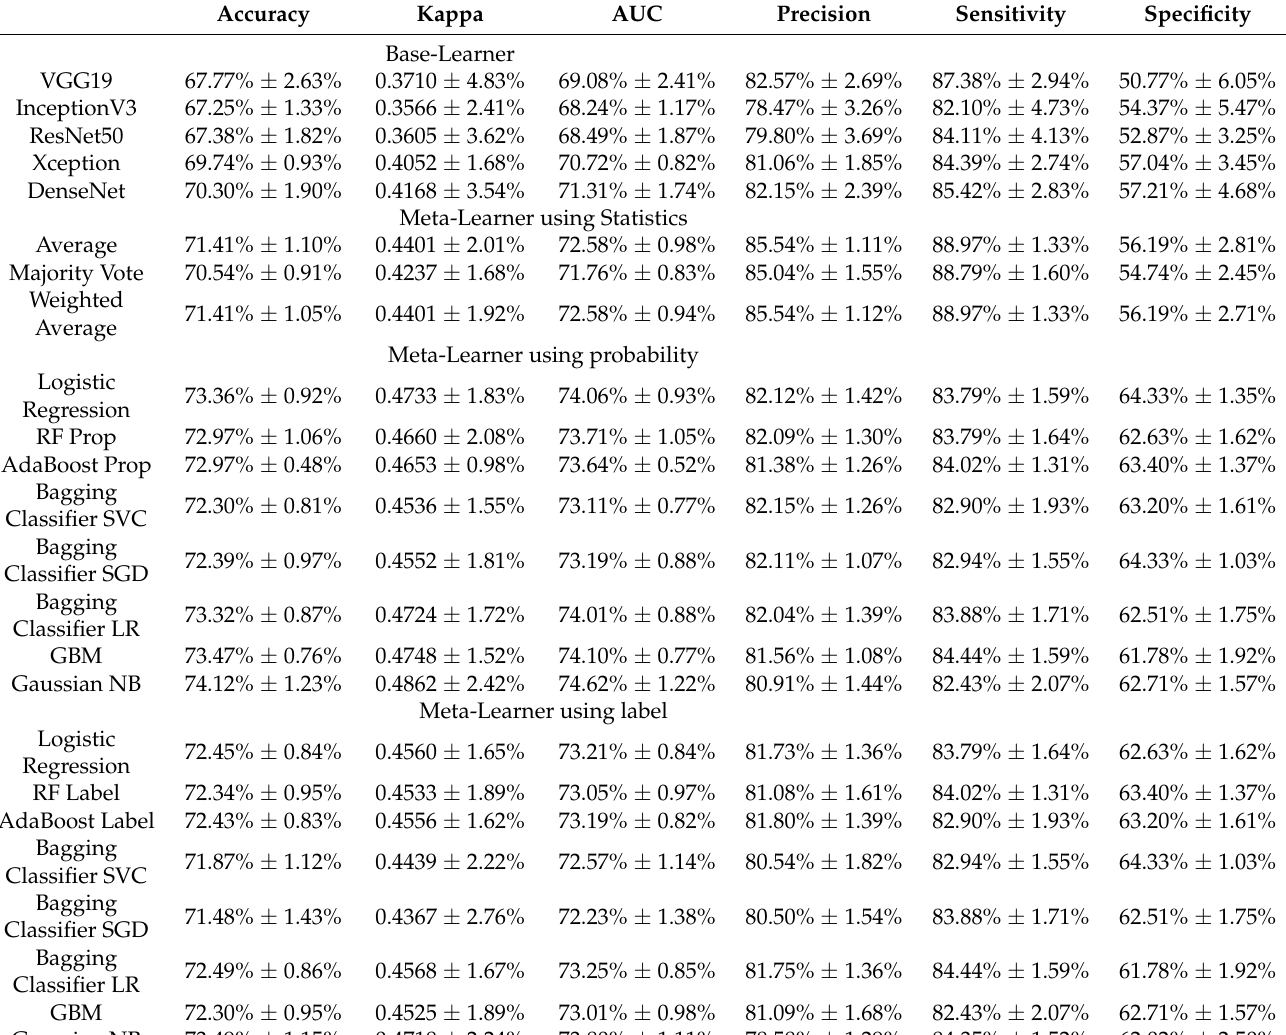
Table A2. The Kappa score achieved by each classifier for the finger images ( ± Confidence Interval 95%). Test performance is